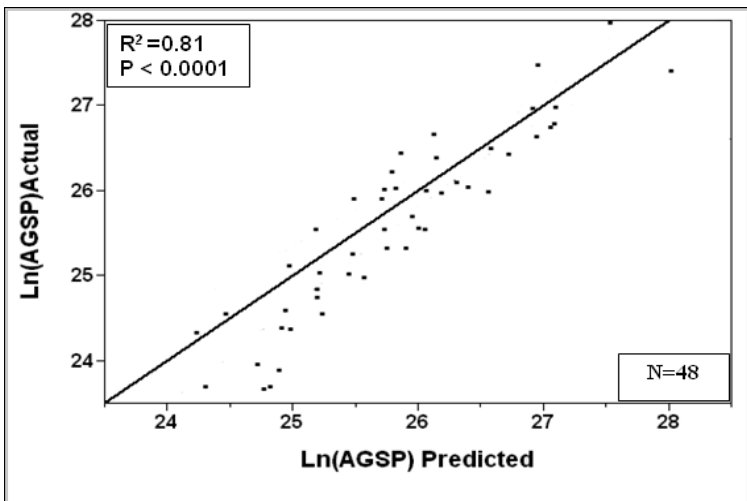
Figure 7. The actual versus predicted plot of the ln( AGSP ) values of the U.S. states derived from the multiple regression model in which natural log of the estimated urban population and ‘sum of lights’ are the predictor